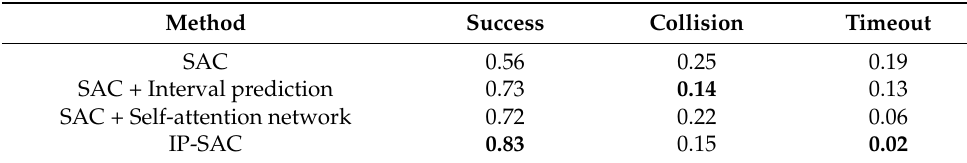
Table 7. Results of the ablation study on different